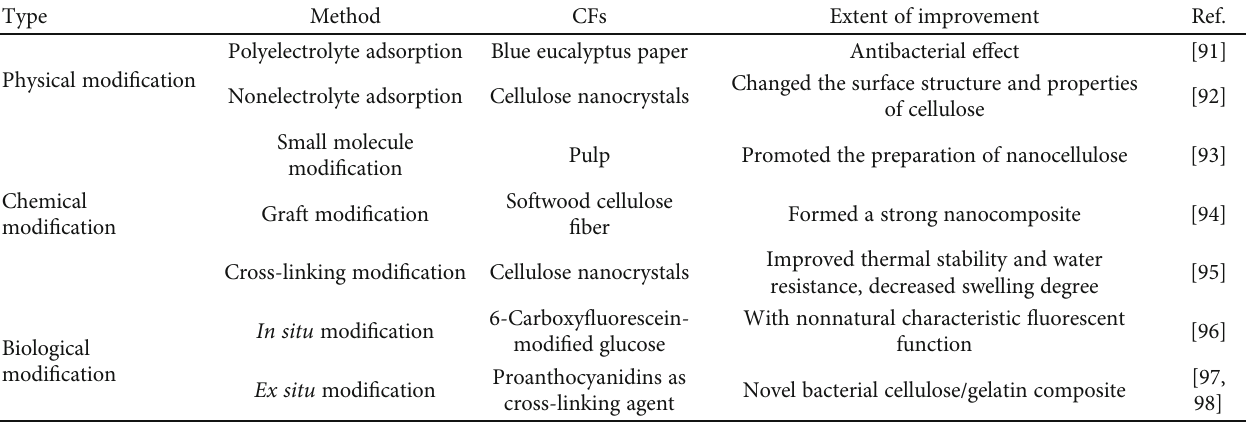
Table 6: Modi fi cation of CFs and the extent of